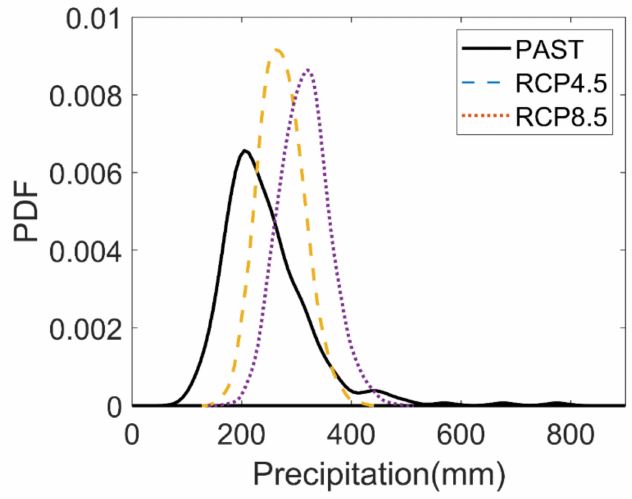
Figure 4. The annual precipitation used to drive the hydrologic